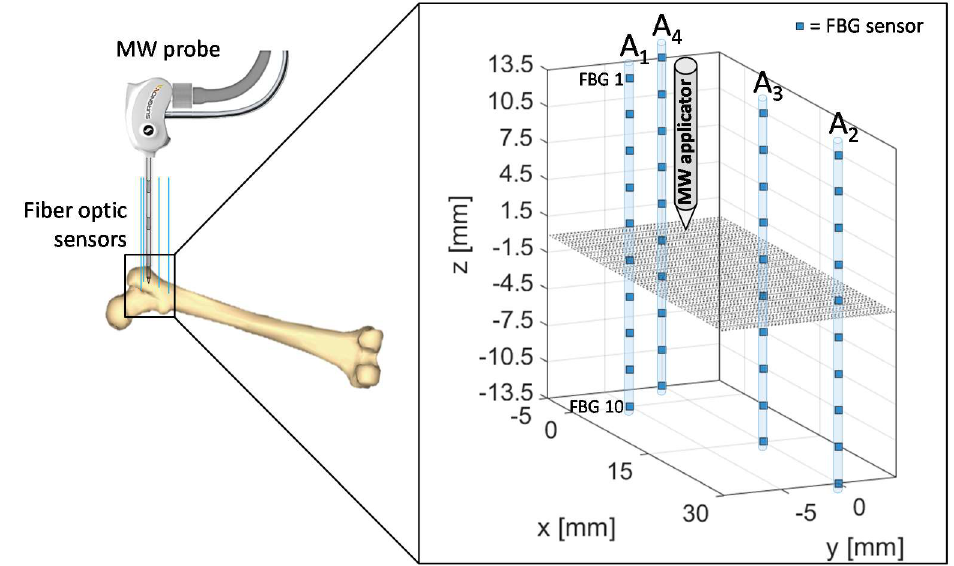
Figure 2. Schematic of fiber Bragg grating (FBGs) and antenna positioning during the microwave ablation (MWA) procedure in the trochanteric tissue of a bovine femur. The antenna tip represents the origin of the coordinate system.